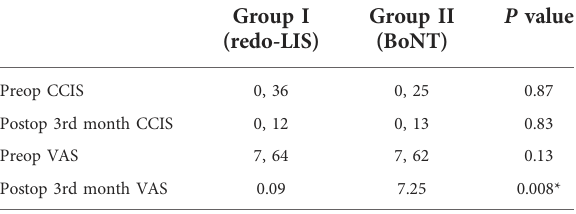
TABLE 2 Study group status by pain and